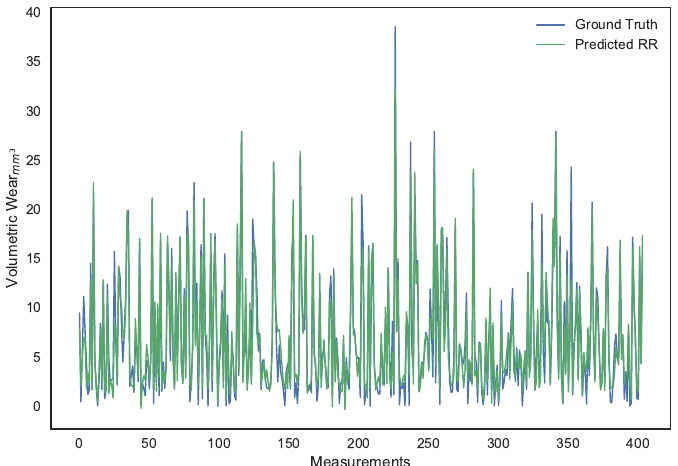
Figure 12. Surface wear prediction on the training set using ridge